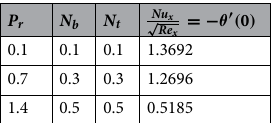
Table 1. Numerical values of P